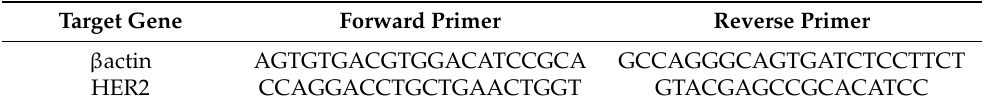
Table 2. List of real-time PCR primer